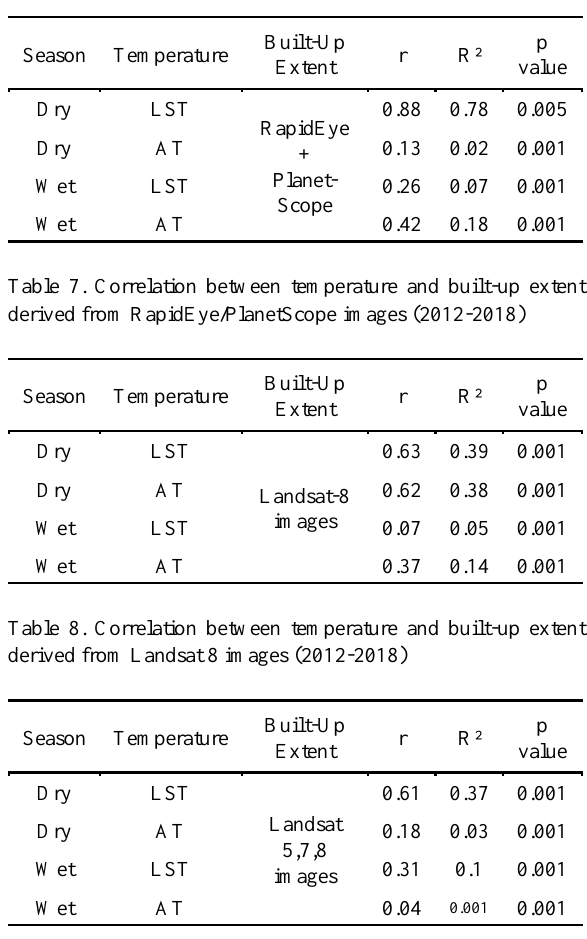
Table 9. Correlation between temperature and built-up